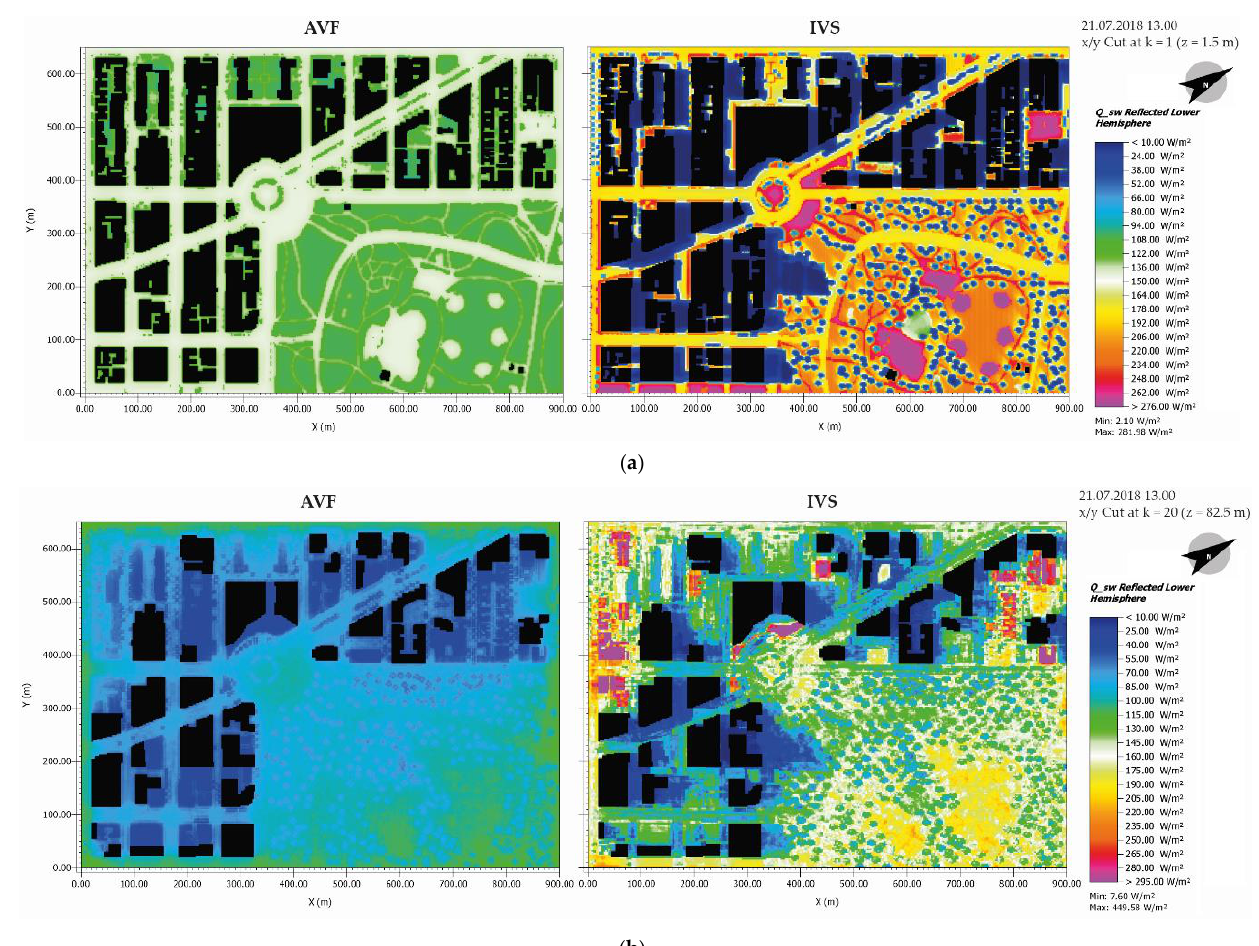
Figure 6. Comparison of proof-of-concept simulation results between AVF and IVS for reflected shortwave radiation received from the lower hemisphere at 13.00 in a height of 1.5 m ( a ) and in a height of 82.5 m ( b ), respectively.